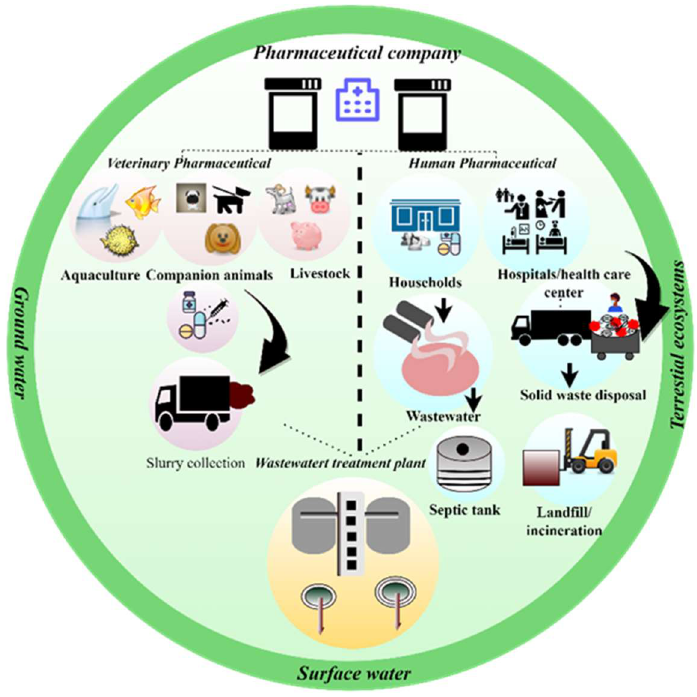
Figure 9. Pharmaceutical waste and wastewater disposal in the environment. Table 7. Wastewater treatment in the pharmaceutical industry.